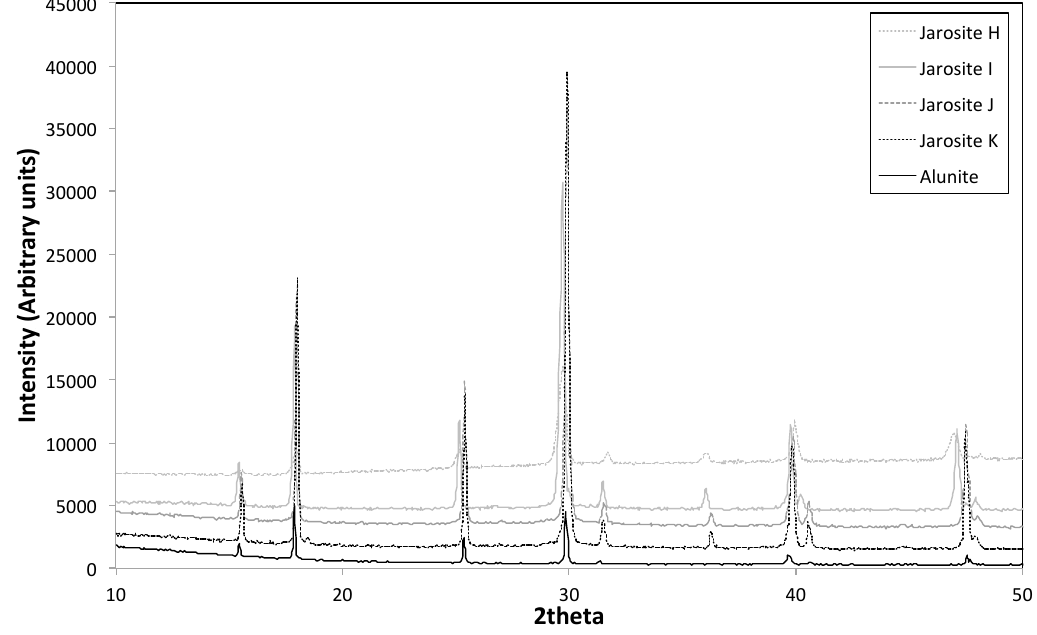
Figure 6. XRD pattern of solids obtained on initial addition of up to 0.9–1.0 mole fraction Al. Patterns have been offset in the y -direction for clarity.